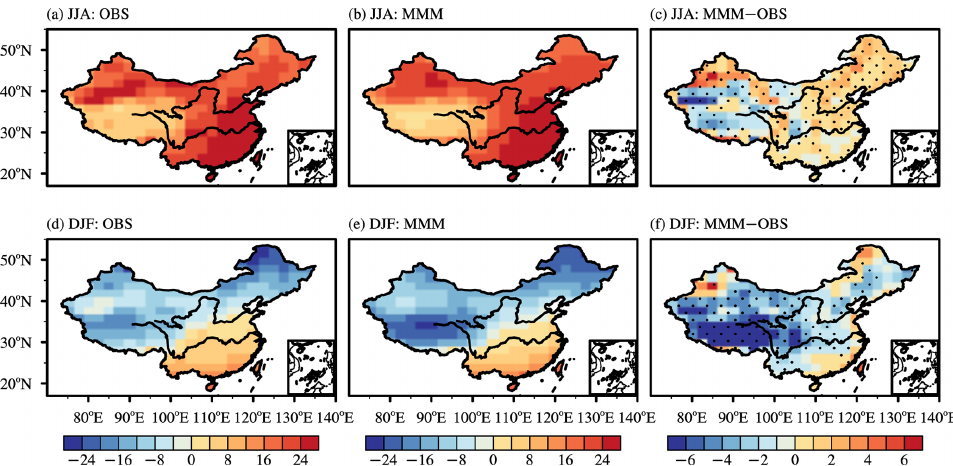
Figure 3. Spatial patterns of surface air temperature climatology (units in ◦ C) over China as obtained from observation ( a, d ; OBS), the multi-model mean ( b, e ; MMM), and the difference between multi-model mean and observation ( c, f ; MMM–OBS) during the period of 1986–2005 in summer (JJA) and winter (DJF). The dots in the far right column indicate areas where at least two-thirds of the models share the same sign of the bias.